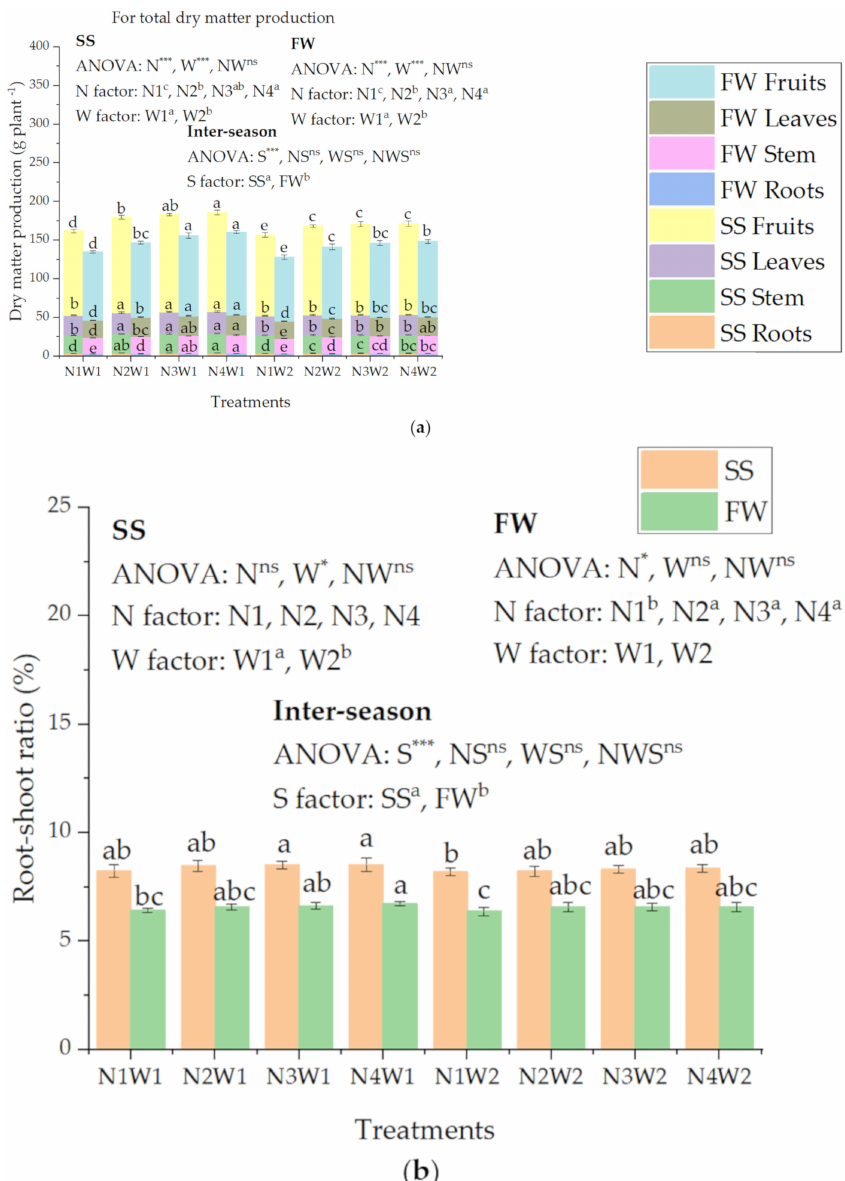
Figure 4. Effects of emitter density, irrigation level, and season on ( a ) dry matter production and ( b ) root/shoot ratio (root dry matter/(stem and leaves dry matter × 100, %) for both SS and FW. N1, N2, N3, N4, W1, W2, SS, and FW; one emitter per plant, two emitters per plant, three emitters per plant, four emitters per plant, full irrigation, deficit irrigation, spring-summer cropping season, and fall-winter cropping season, respectively. *, ***, ns: significant at p < 0.05, significant at p < 0.001, and non-significant at p > 0.05. Values that are followed by different letters within the same columns differ significantly at p < 0.05. Data were given in means ± standard deviations ( n = 4) shown by vertical